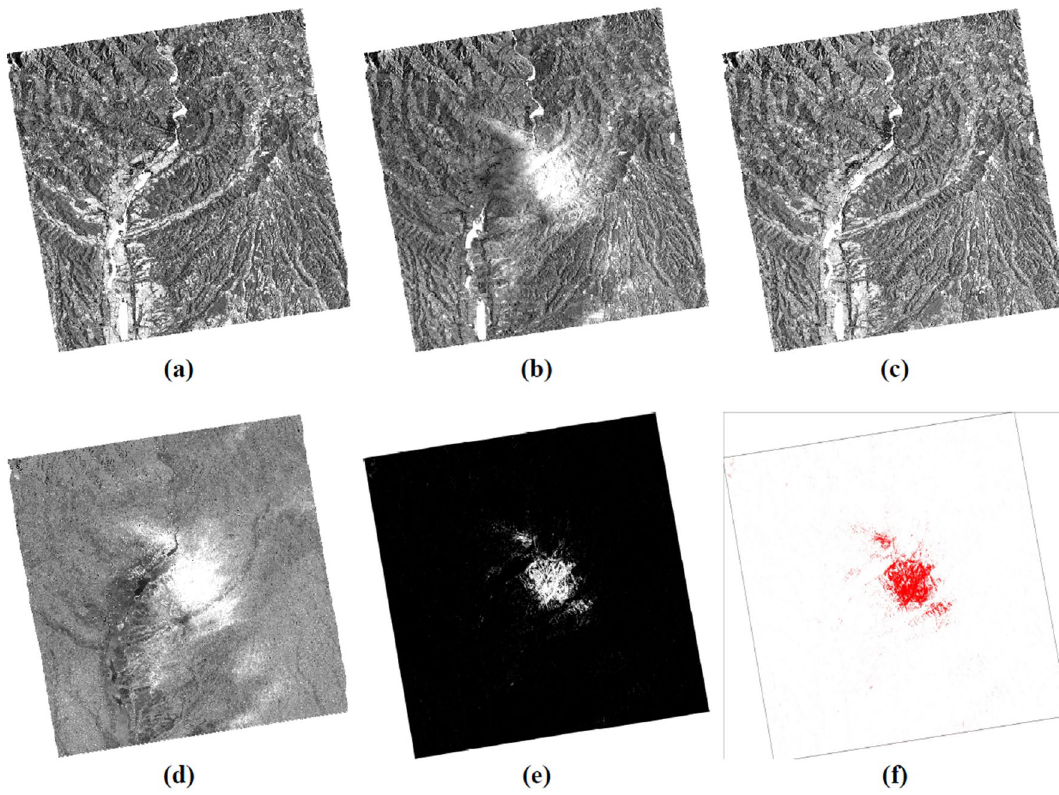
Figure 4. Steps for extraction of water surfaces from a VV and VH combination; ( a ) σ0 VVxVH (db), 14/05/2020; ( b ) σ0